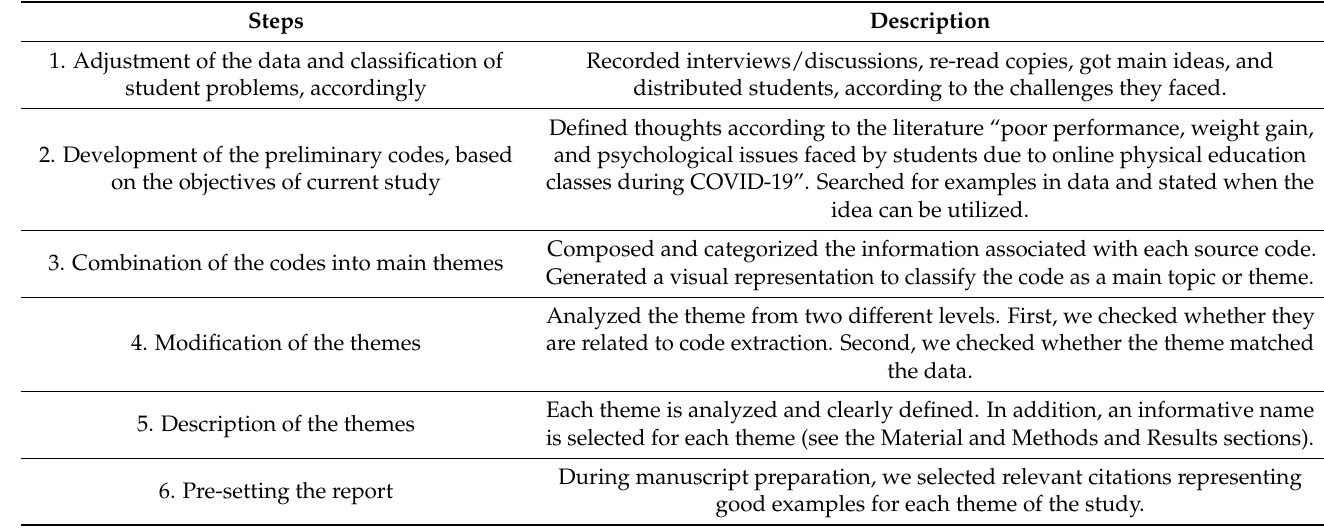
Table 3. Description of the steps followed in the thematic analysis.